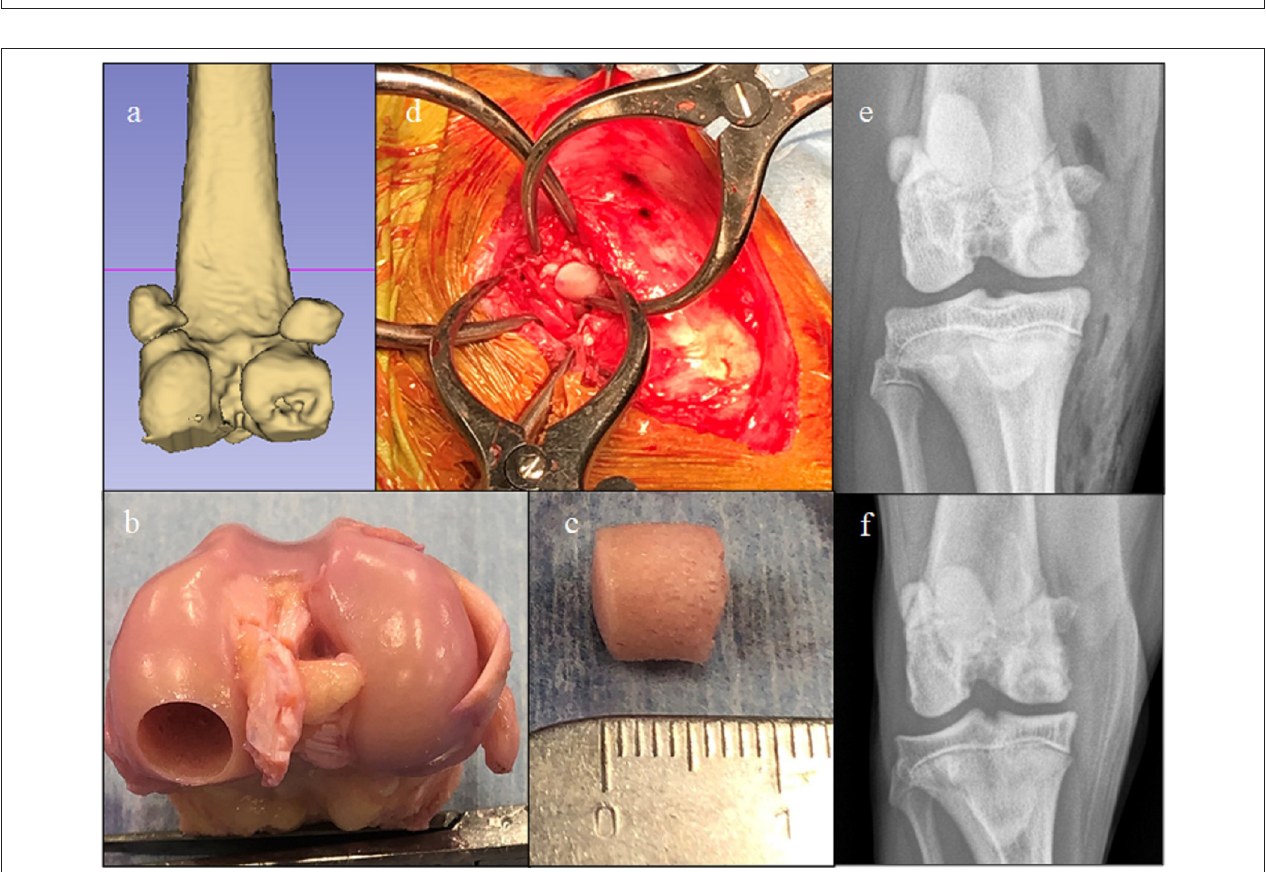
was > 70% of established reference range at time of clearance ( Figure 1 ) (15, 16). Handling of OCA was done in compliance with US Food and Drug Administration guidelines for human OCAs (section 361 of the Public Health Services Act). All OCAs were implanted within 56 days of donor death because a previous study has shown that all MOPS R (cid:13) -preserved canine donor tissue exceeds minimum essential viable chondrocyte density up to 56 days following tissue recovery